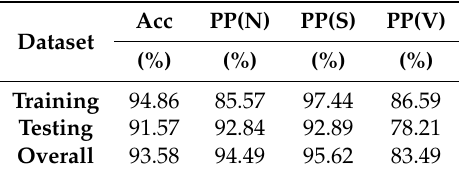
Table 4. Values of overall accuracy (Acc), PP(N), PP(S), and PP(V) for the testing, training, and total datasets.